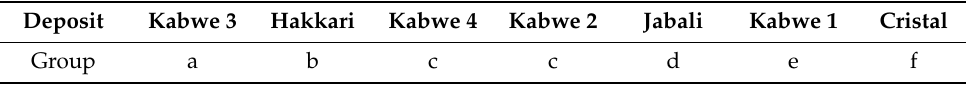
Table 2. Results of the post hoc Tukey’s HSD